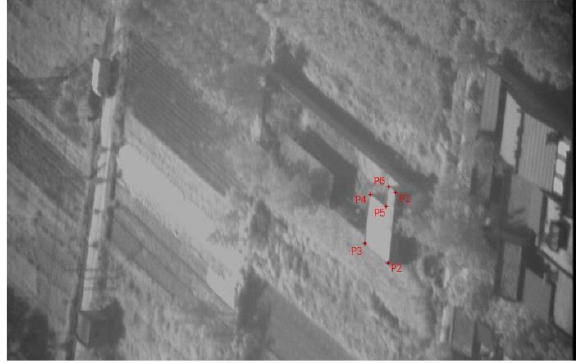
Figure 6 . Distribution Map of GCPs.